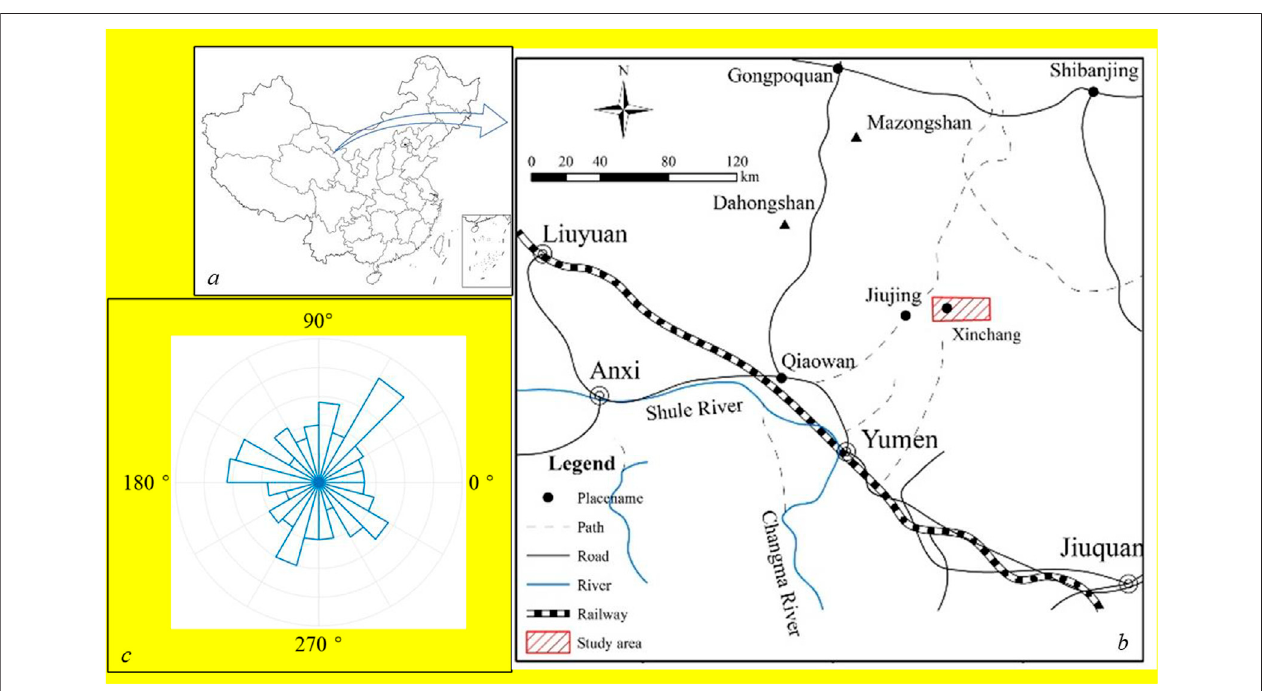
FIGURE 1 | Location map of the case study area. (A,B) : Location description of study area; (C) : The rose diagram of the joins trend.